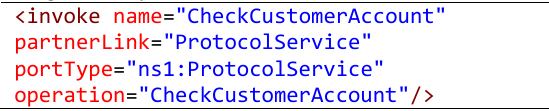
Fig. 9. Replaced Constructor of the Invoke Activity depicted in Figure 8